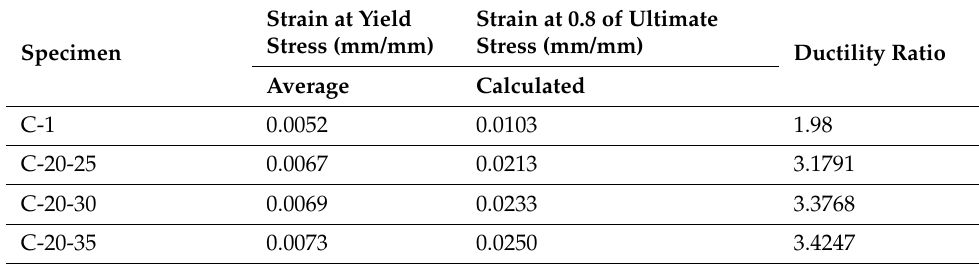
Table 4. Ductility of the tested